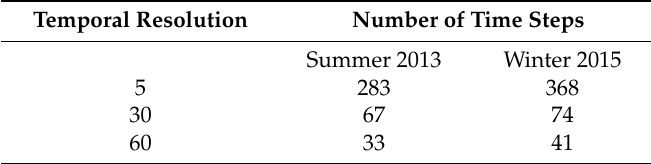
Table 5. The number of time steps remaining for